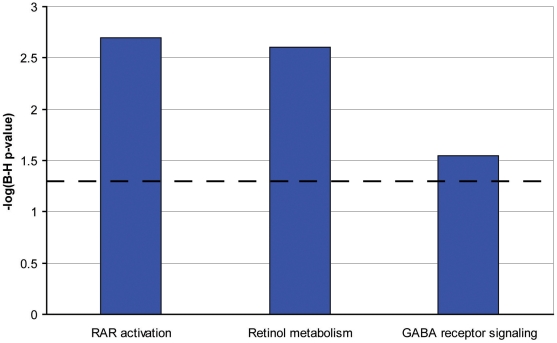
Three canonical pathways identified by Ingenuity software [25] in the group of RPE-specific genes.The three bars represent the canonical pathway identified, the x-axis identifies the pathways. The y-axis shows the −log of the Benjamini-Hochberg (B–H) p-value. The dotted line represents the threshold above which there are statistically significantly more genes in a pathway than expected by chance.